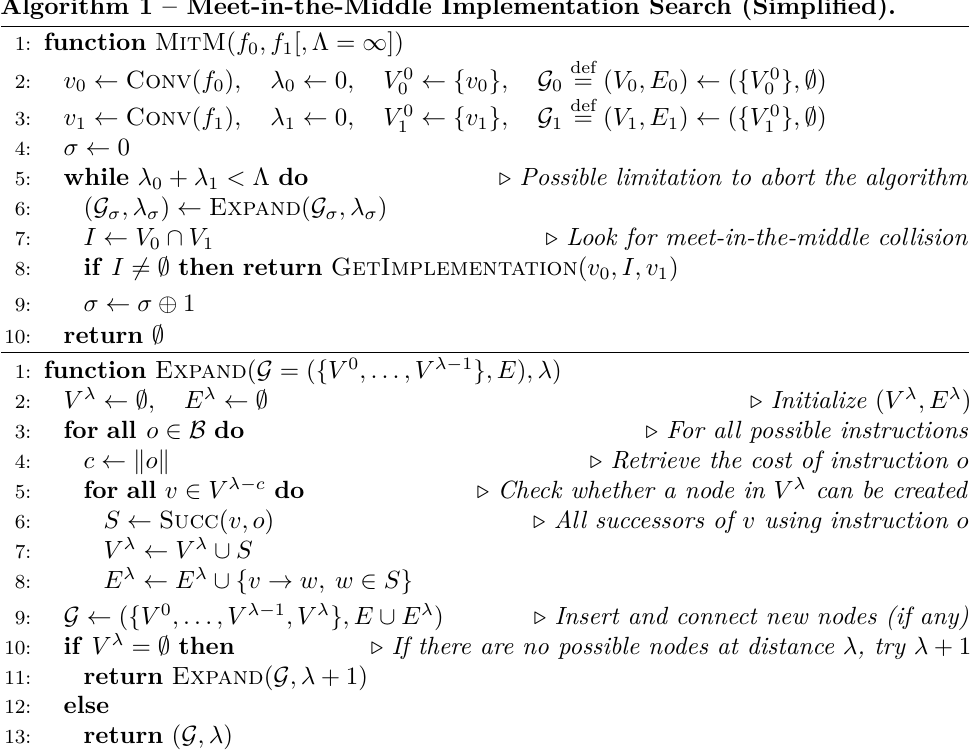
Algorithm 1 – Meet-in-the-Middle Implementation Search (Simplified).